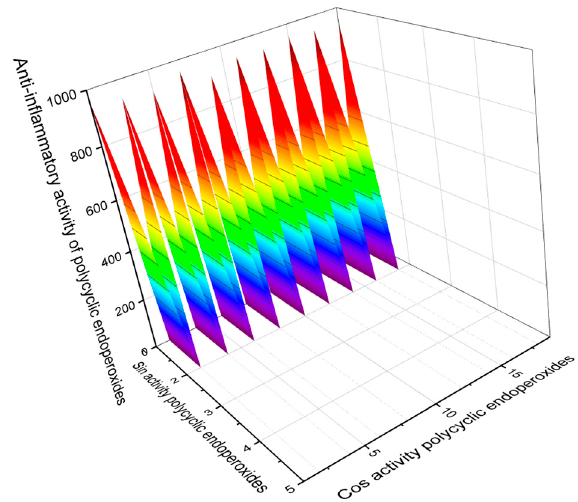
Figure 15. The 3D graph shows the predicted and calculated anti-inflammatory activity of selected polycyclic endoperoxides (compound numbers: 1 , 8 , 9 , 68 , 94 , 95 , 96 , 97 , 98 , 100 , and 113 ) showing the highest degree of confidence, i.e., more than 95%. These polycyclic endoperoxides can be used as potential agents with strong anti-inflammatory activity.